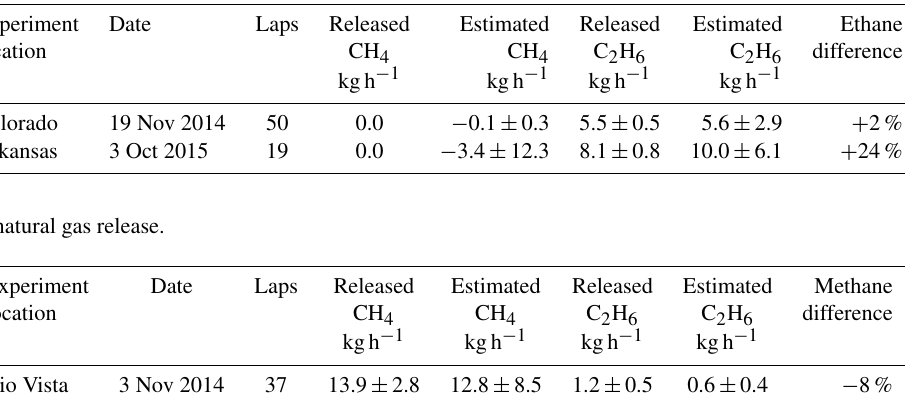
Table 2. Controlled ethane releases.